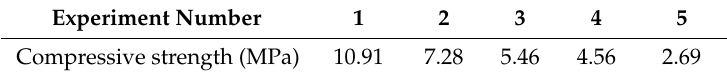
Figure 10. The stress-strain curves of the core for different experiment. Table 5. Uniaxial compressive strength of cores of different testing